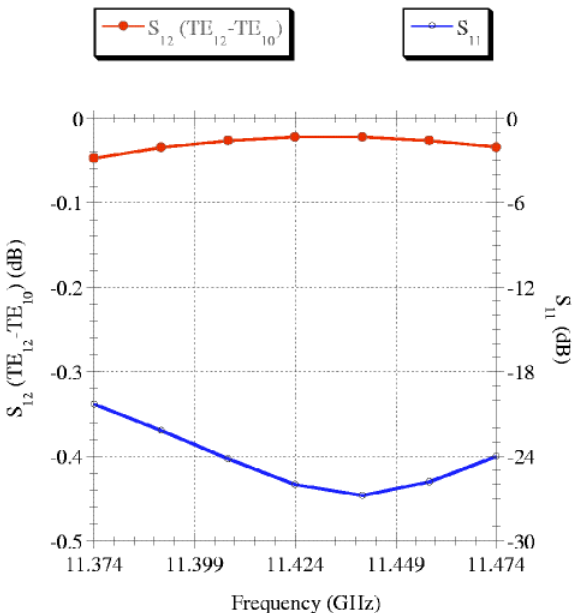
FIG. 8. (Color) Simulated performance of the TE 10 (rectangular) to TE 12 (circular) mode converter. Simulations were done using HP-HFSS.